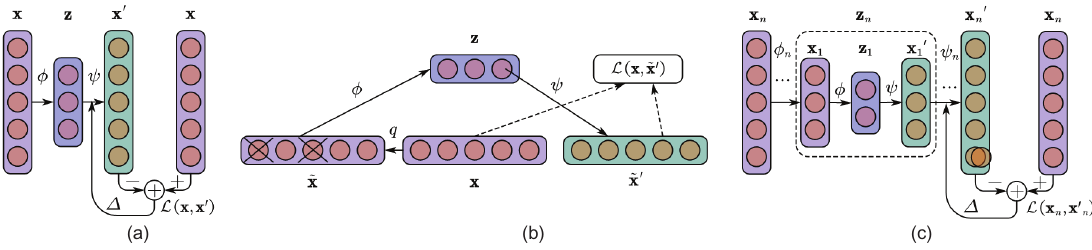
Figure 5. Architectures of the ( a ) AE; ( b ) denoising AE; and ( c ) stacked AE